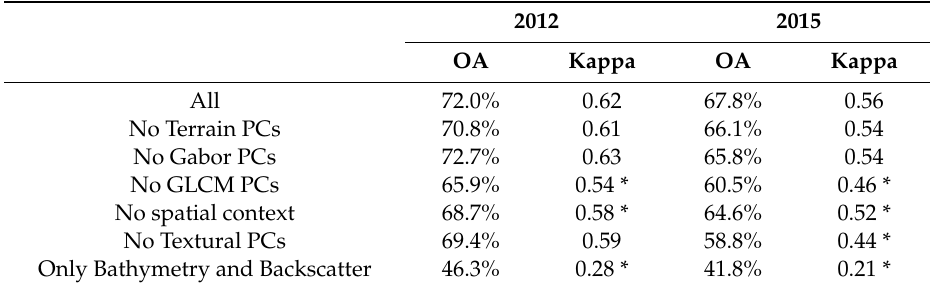
Table 12. Sensitivity analysis of model accuracy to the exclusion of di ff erent features